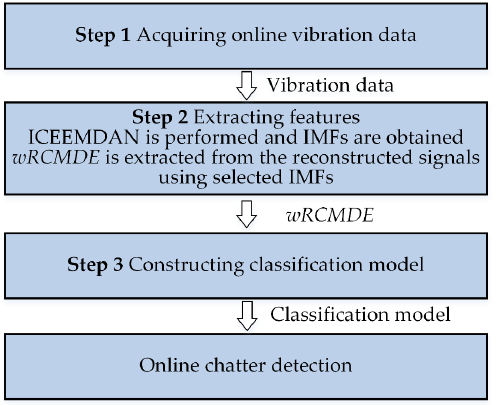
Figure 1. The framework for the proposed chatter detection system.